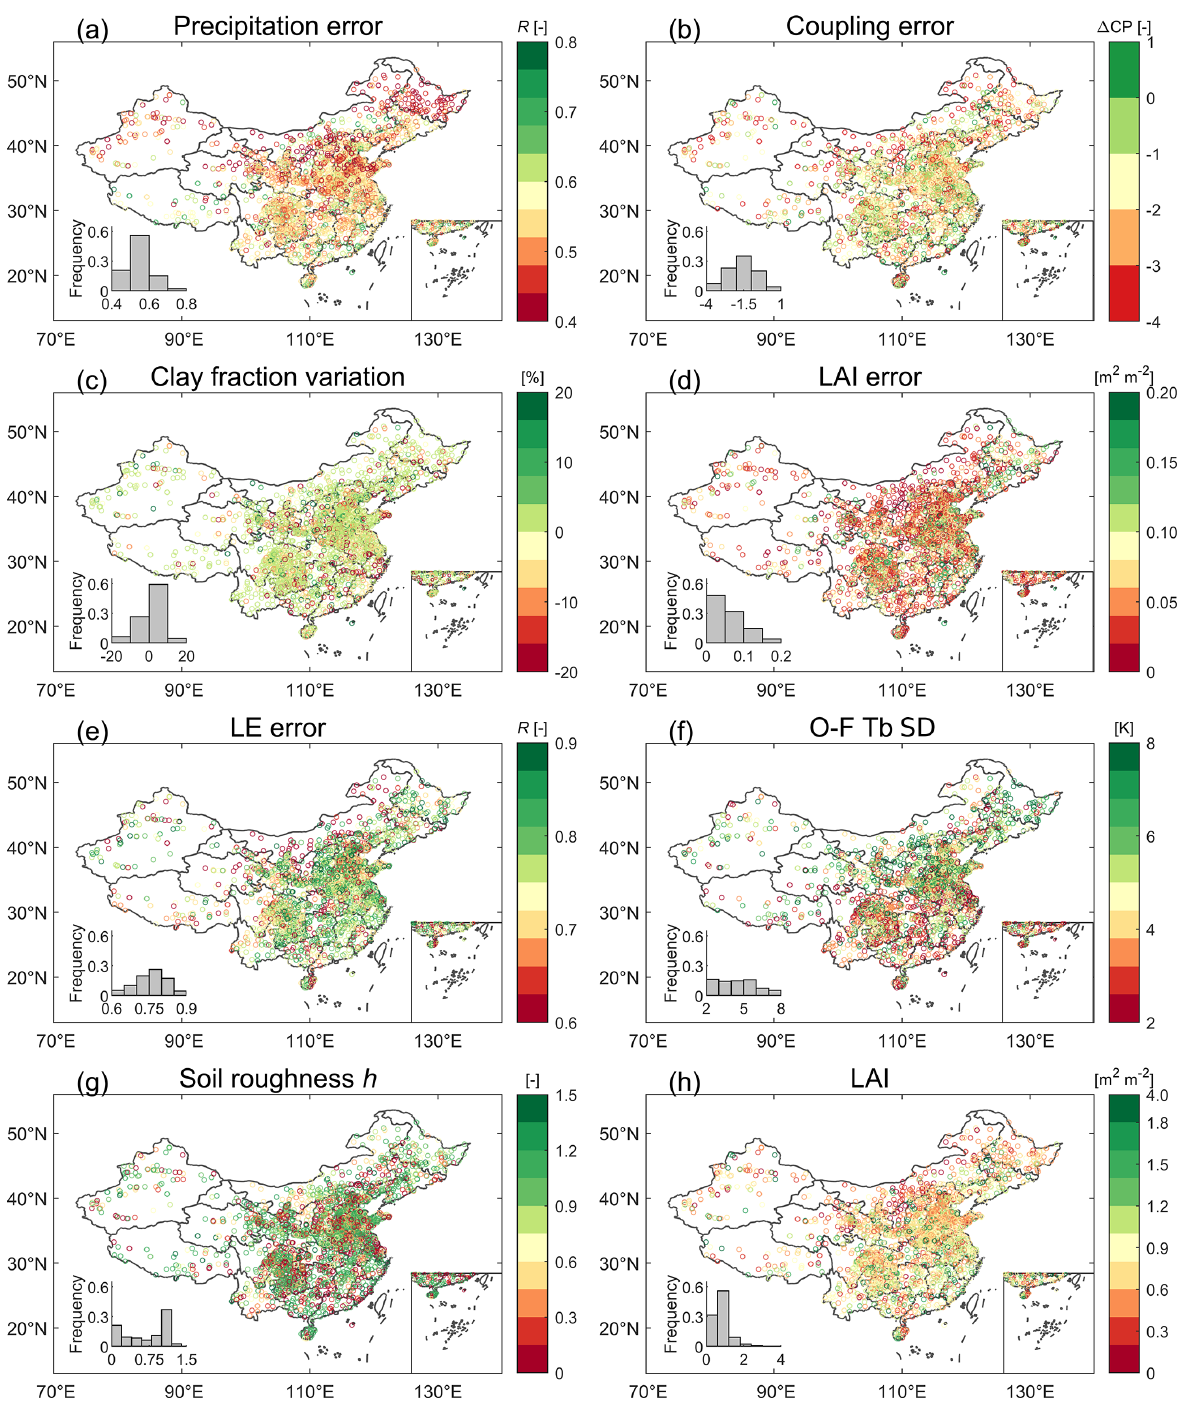
Figure 4. Factors potentially influencing SMAP L4 performance over the study area: (a) CLSM precipitation error measured by the Spear- man’s rank correlation between CLSM precipitation and ground observations; (b) SSM–RZSM coupling strength error (CP OL minus CP obs ); (c) clay fraction variation (difference) across the soil profile; (d) error in LAI input to L4; (e) IV d -based error of LE from L4; (f) O − F T b standard deviation; (g) L4 microwave soil roughness; (h) climatology mean of LAI input to L4. The last row shows factors that consist of the magnitude of the variable itself, while the other rows show factors based on estimates of the errors that are fed into the L4 system.